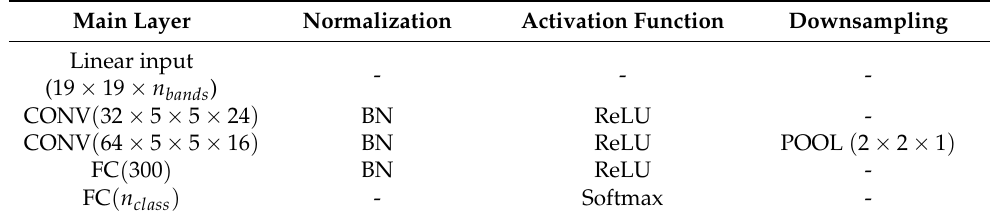
Table 2. Architecture of the 3DCNN